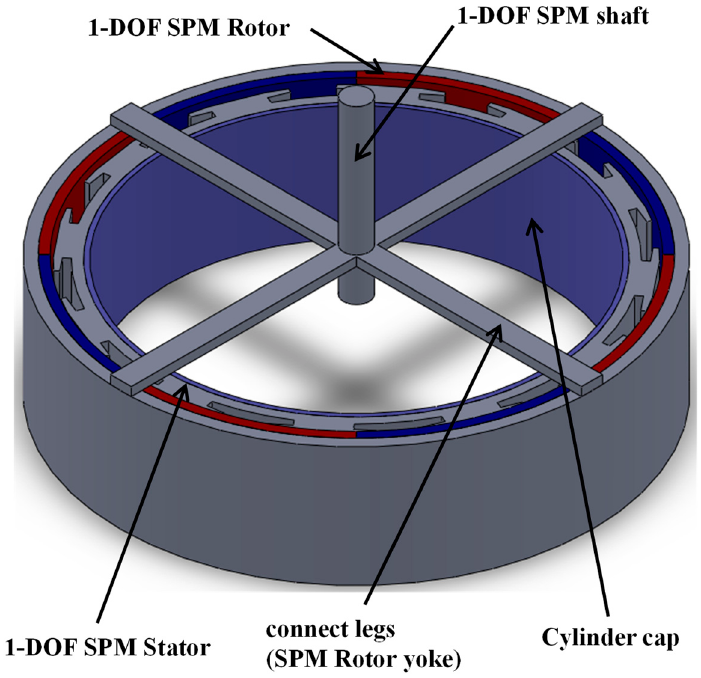
Figure 3. Rotating motor of the HMDOF motor.